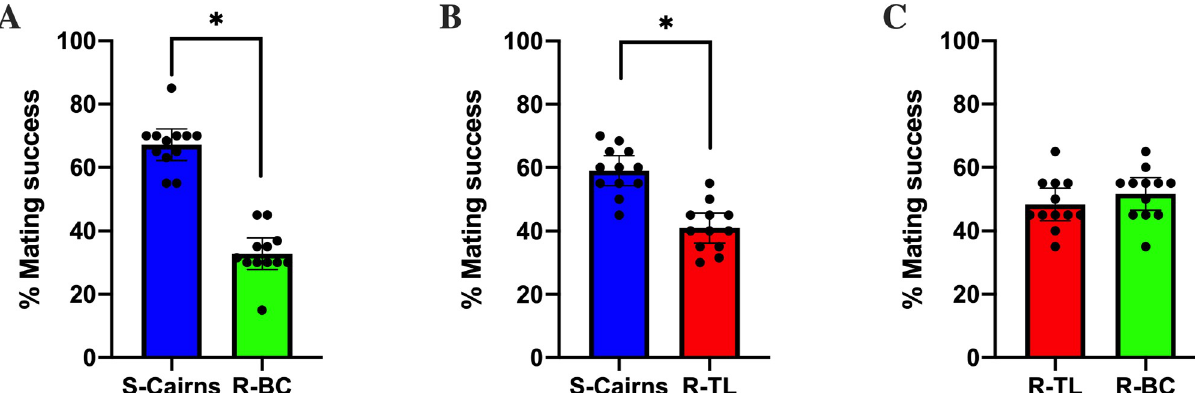
Fig 2. Percentage mating success. Mating success between (A) males from the S-Cairns and R-BC strains (B) males from the S-Cairns and R-TL strains (C) males from R-BC and R-TL strains (Mean ± 95% CI). ( � : significantly different due to non-overlapping confidence intervals).